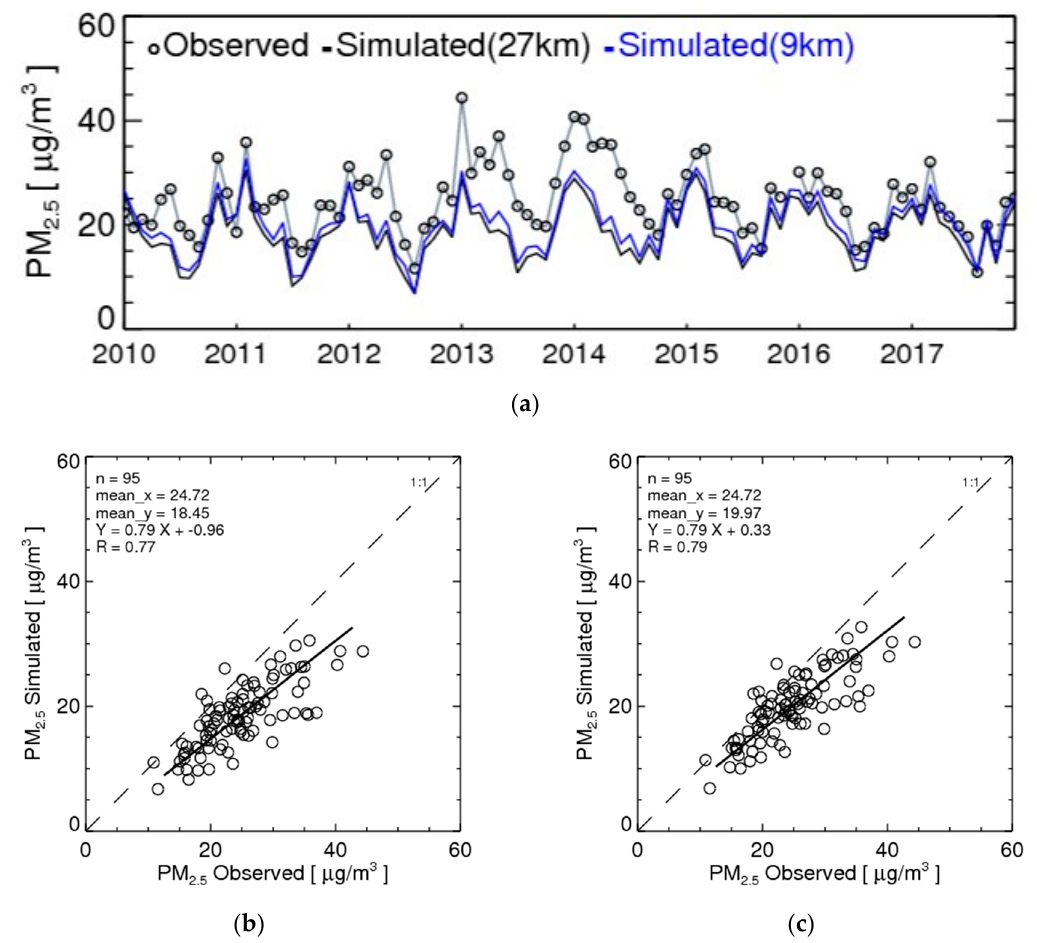
Figure 3. ( a ) Time series of the monthly means of the observed and the 27- and 9-km simulated particulate matter of 2.5 μ m or less in diameter (PM 2.5 ) concentrations averaged across the six supersites in South Korea. Scatter plots of the ( b ) 27- and ( c ) 9-km simulations. Table 4. Comparison of the monthly averages of the observed and simulated PM 2.5 concentrations and performance statistics for the 27- and 9-km simulations across the six supersites from 2010 to 2017. Site